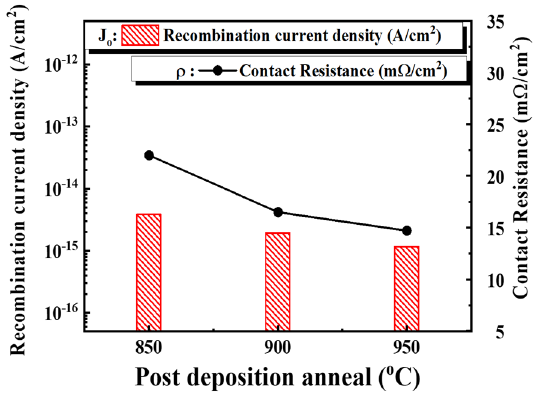
Figure 5. Improvements in recombination current density and contact resistance after FGA annealing of the annealed nc-SiO x layer.